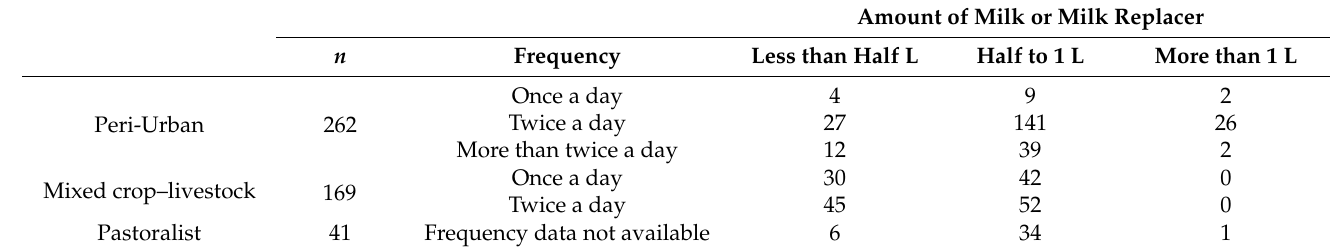
Table 11. Frequency and volume of milk fed by production system.